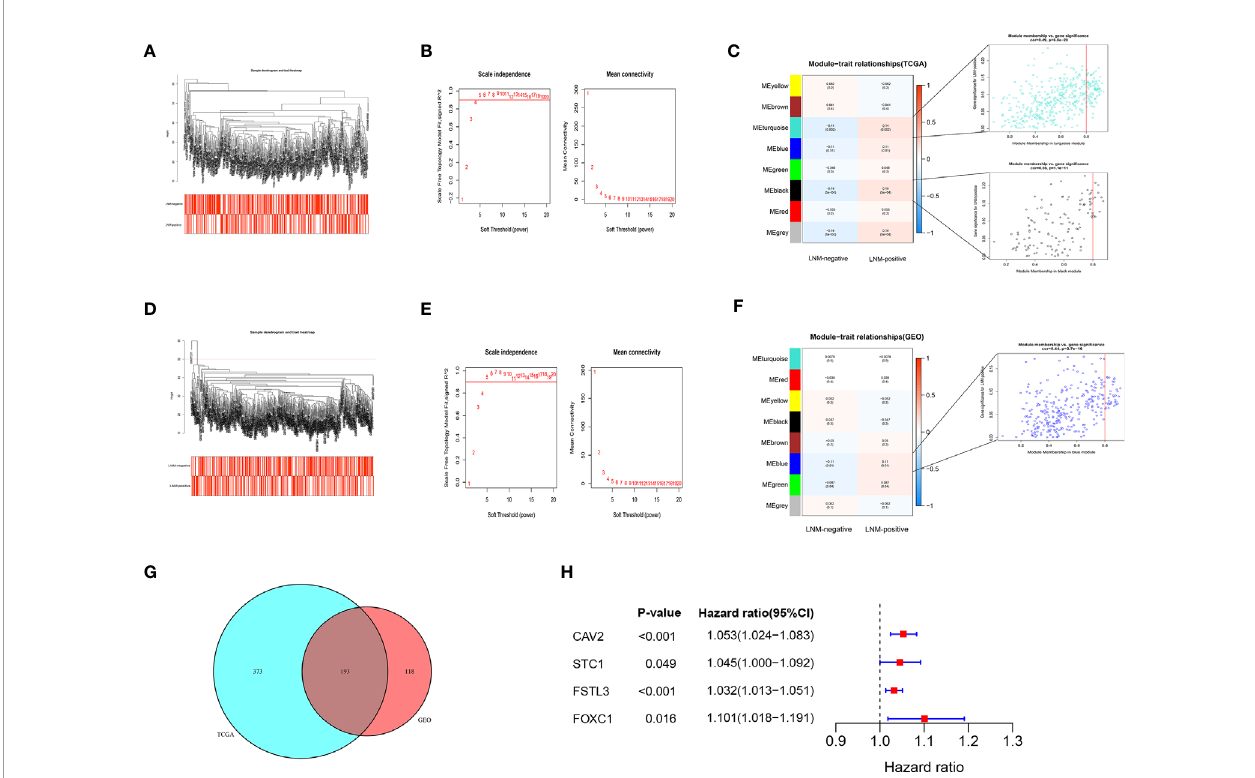
FIGURE 5 | Identi fi cation of key gene by WGCNA. (A) The sample clustering tree of CRC samples in the TCGA cohort, and all patients have passed the cut. The color band under the sample clustering tree presents the patients with or without LNM. Red box represents LNM-positive and white box represents LNM-negative. (B) The scale independent value exceeds 0.9 with a low average connectivity when soft threshold power was 5. The left image shows the relationship between the soft-threshold and scale-free R 2 . The right image shows the mean connectivity for each soft-threshold. (C) Heatmap of the correlation between gene modules and clinical traits of CRC. The numerical value in each cell represents the correlation coef fi cient. Values within parentheses are P -values. The right images show the scatterplot of Gene Signi fi cance vs. Module Membership in the black and turquoise modules. (D) The sample clustering tree of CRC samples after removing one outlier sample (GSM972311) in the GSE39582 cohort. (E) The scale independent value exceeds 0.9 with a low average connectivity when soft threshold power was 5. (F) Heatmap of the correlation between gene modules and clinical traits of CRC. (G) Venn diagram showed that there were 193 overlapping genes related to LNM status in the TCGA and GSE39582 cohorts. (H) The forest plot showed that four genes were considered to be closely related to